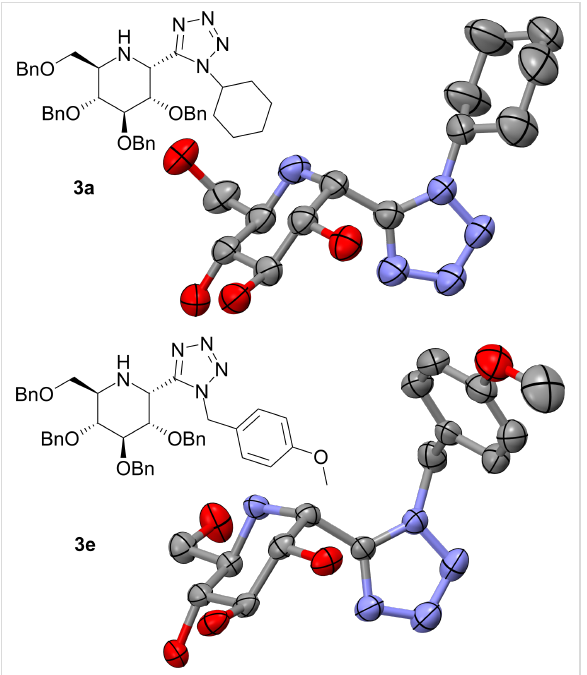
Figure 2: ORTEP structures of compounds 3a and 3e obtained by X-ray analysis. Hydrogen atoms and benzyl groups are omitted for clarity. Full crystallographic data available in Supporting Information File 2 and Supporting Information File 3, and in Cambridge Crystallo- graphic Database under CCDC-2001373 and CCDC-2001372 numbers, respectively.